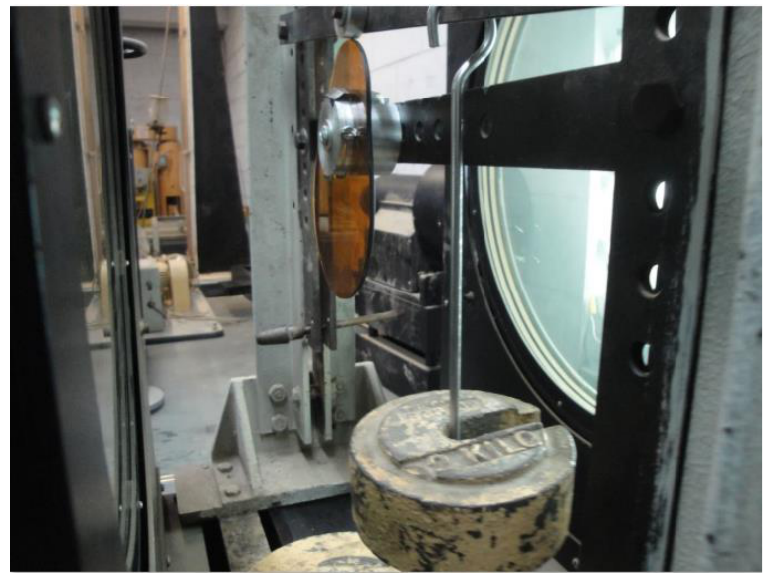
Figure 10. Cam installation on the shaft through square grooving key.